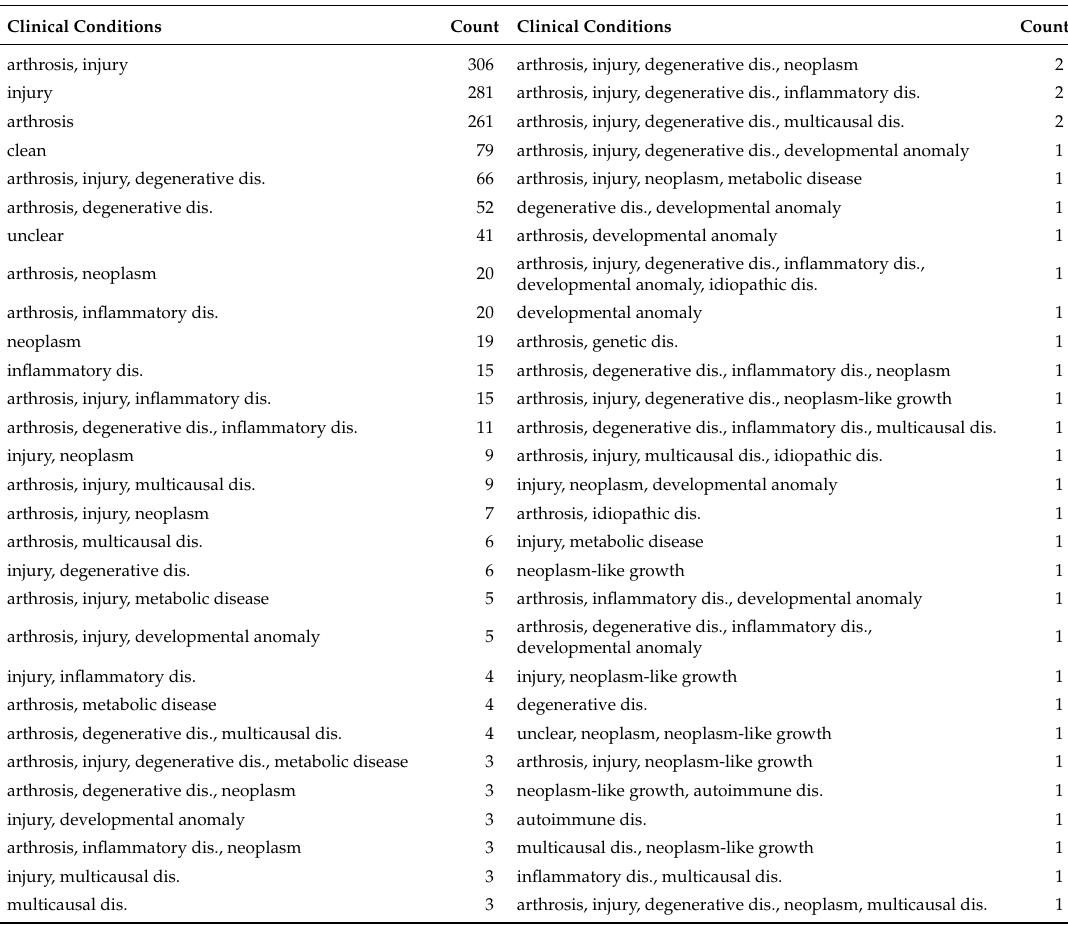
Table 2. Observation counts for each unique set of clinical conditions appearing in the radiology reports used for this research. Sets of clinical conditions are shown in descending order with respect to their observation